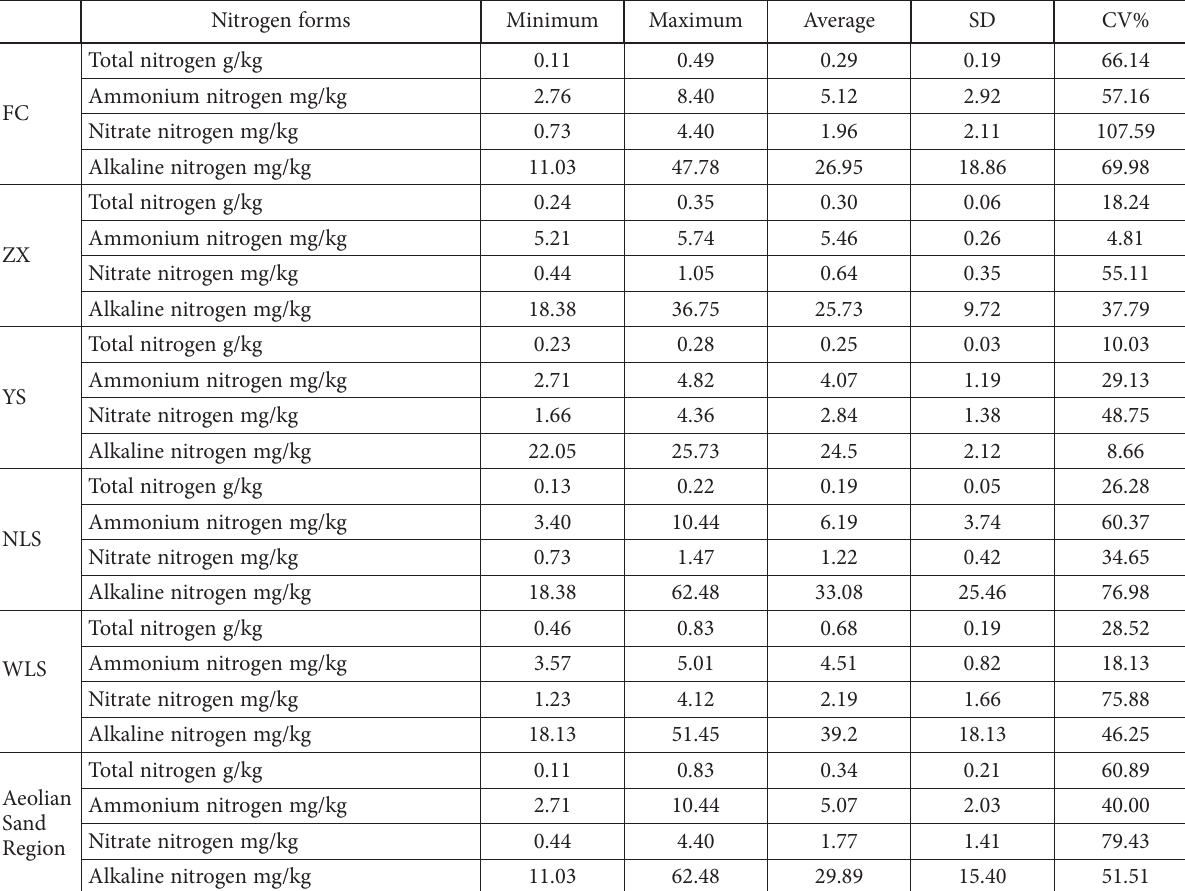
Table 7. Statistical analysis of nitrogen forms and contents in soil of the aeolian sand region (2016) Nitrogen forms